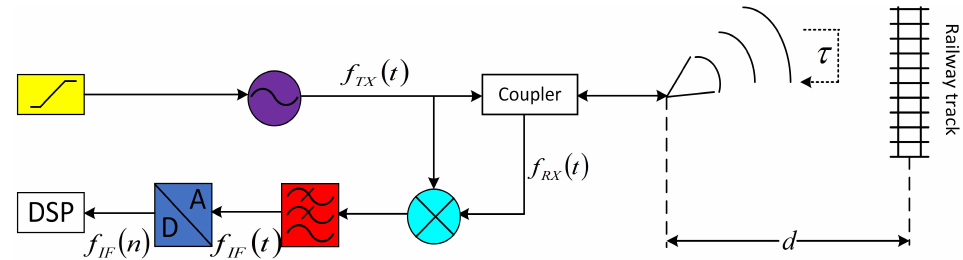
Figure 5. Block diagram of the FMCW radar